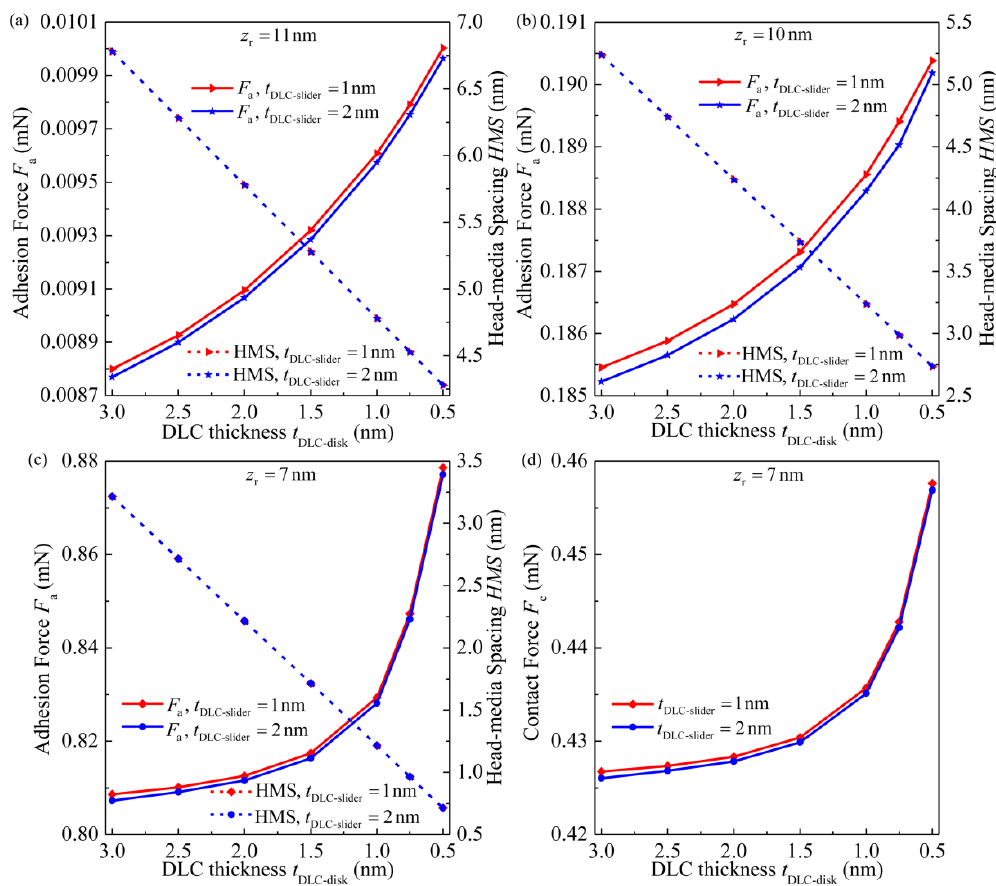
Figure 12. Influence of the DLC thickness of the disk on the adhesion force, HMS ( a ) flying heights of height of 10 nm; ( c ) flying height of 7 nm; ( d ) DLC thickness versus contact force for flying height of 11 nm; ( b ) flying heights of 10 nm; ( c )flying heights of 7 nm; ( d ) contact force under l c = 10 nm, t lub = 2 7 nm, under l c = 10 nm, t lub = 2 nm.